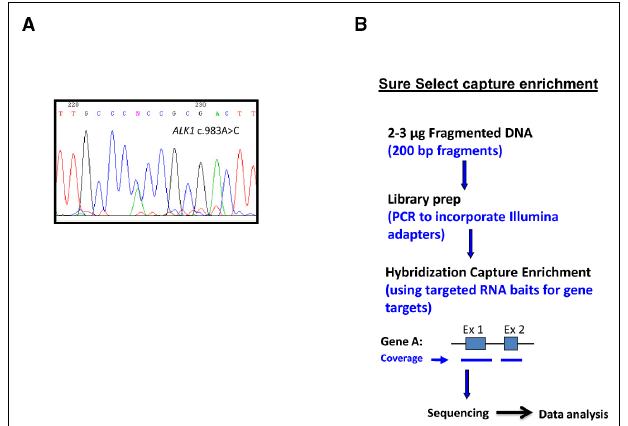
FIGURE 3 | Circulating protein biomarkers in HHT. (A) The levels of TGF- b 1 secreted (over 7 h) by 15 different HUVEC with HHT1 were significantly different (* p < 0.05) from the control HUVEC (C) tested in the same experiment. (B) VEGF plasma concentration levels in 25 healthy controls and 18 HHT patients. The mean values and the standard deviation are given for each group (* p < 0.001). (C) Plasma levels of Ang-2 and (D) plasma levels of sEng in healthy donors ( n = 38), patients with HHT1 ( n = 32) and patients with HHT2 ( n = 30). Significant differences between groups (** p < 0.01) are shown. Adapted from Letarte et al. (2005) (A) , Sadick et al. (2005) (B) , and Ojeda-Fernandez et al. (2010) (C,D)